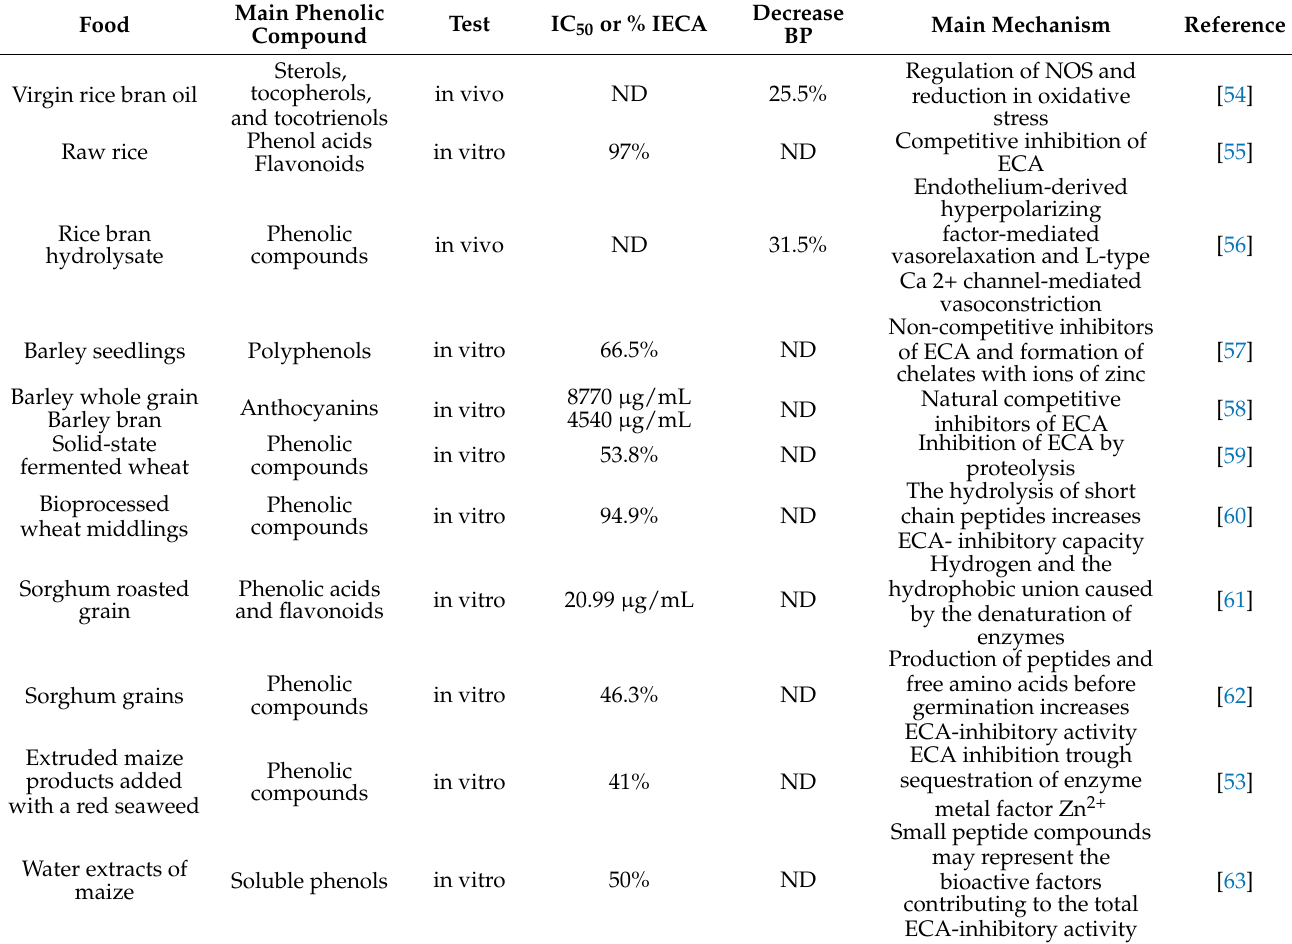
Table 1. Phenolic compounds derived from cereals with antihypertensive